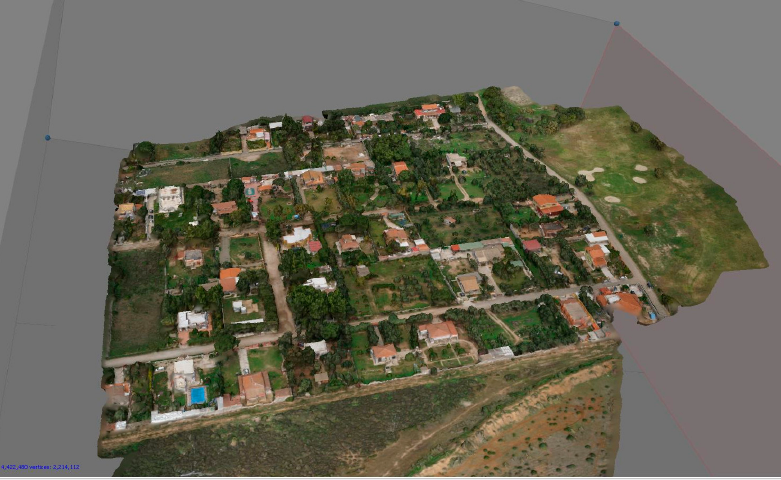
Figure 6. Photoscan mesh.